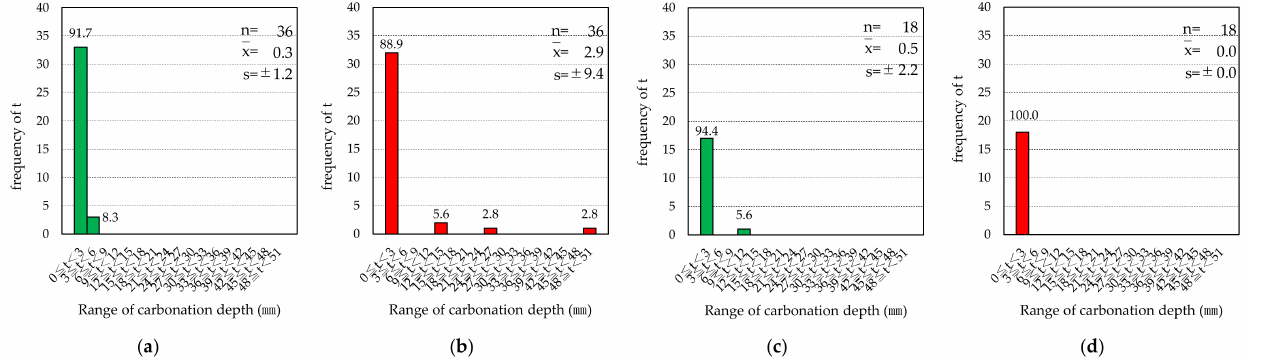
Figure 8. Effect of external insulation on the carbonation depth of the outer wall concrete with a mortar layer. ( a ) Bldg. E, NE wall with external insulation, ( b ) Bldg. E, NE wall without external insulation, ( c ) Bldg. F, NE wall with external insulation, ( d ) Bldg. F, NE wall without external insulation. Data labels indicate percentages.